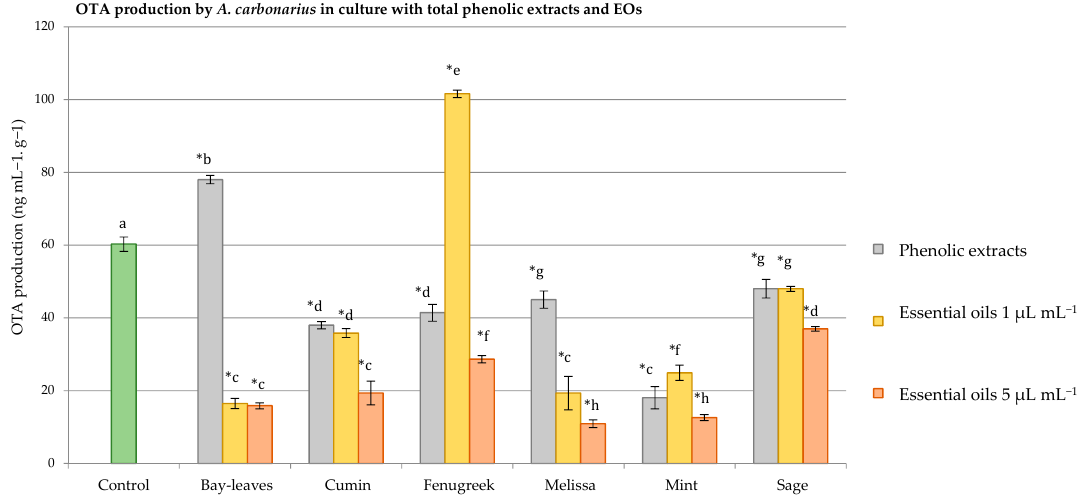
Figure 4. Graphical comparison between the effects of phenolic extracts and essential oils at 1 and 5 µ L mL − 1 on the ochratoxin A (OTA) produced by A. carbonariuss S402 cultured in a synthetic grape medium at 28 ◦ C for 4 days. Statistical differences are indicated as: * = significant difference ( p < 0.05). Data with the same letters are not significantly different ( p < 0.05).